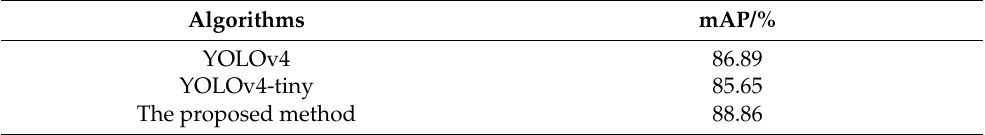
Table 1. Performance comparison of different object detection